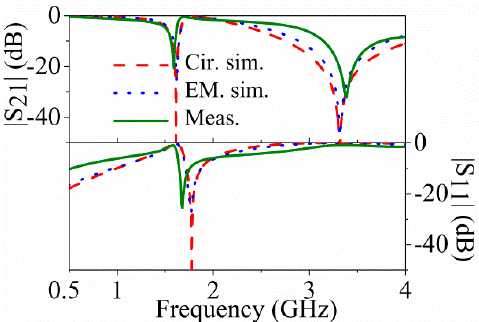
Figure 10. Electromagnetic simulation, circuit simulation and measurement response for the asymmetric structure of Figure 7c. Reprinted with permission from [11].